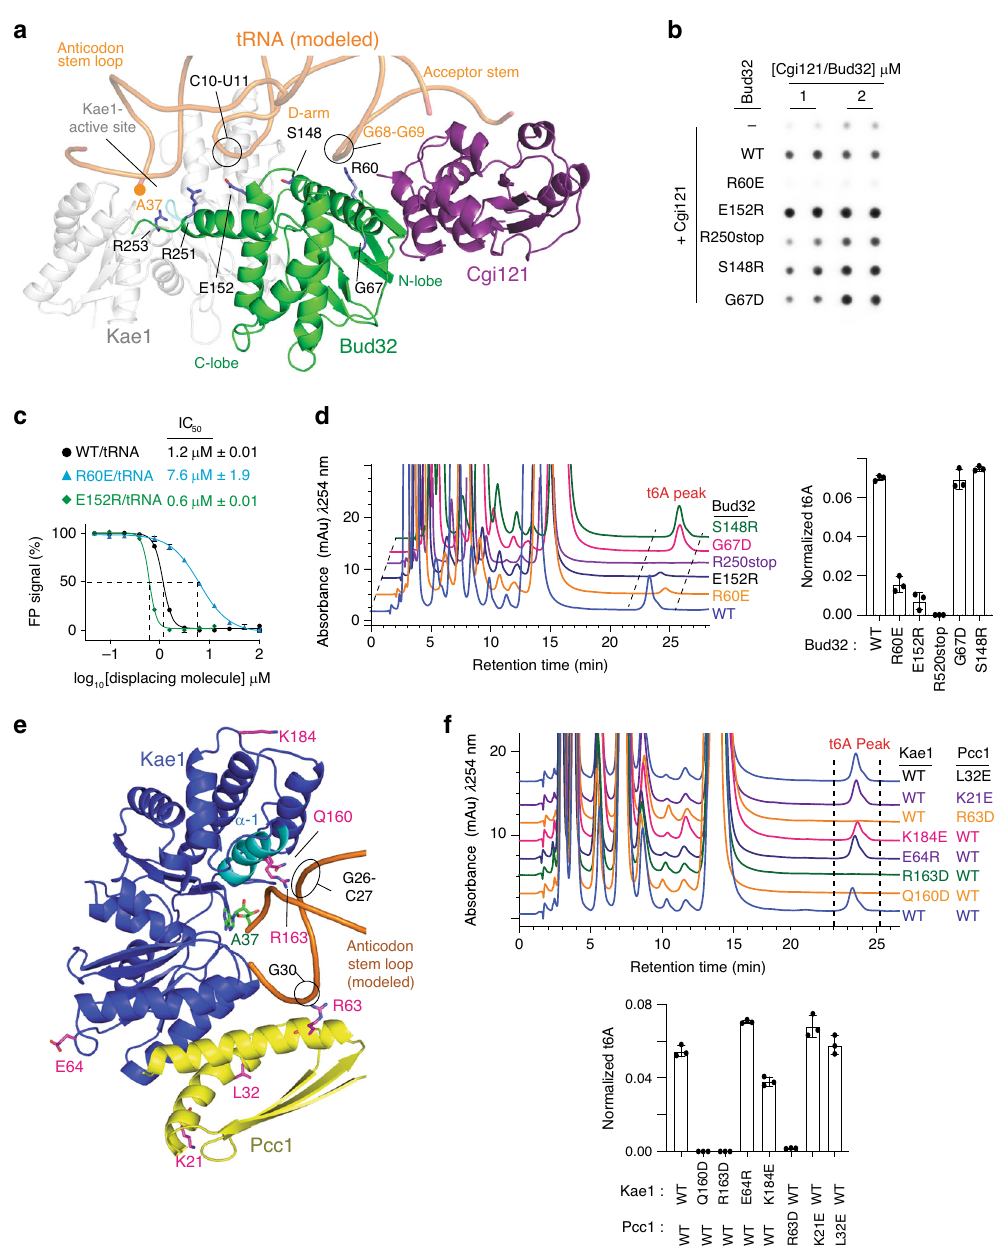
Fig. 5 All KEOPS subunits contribute to a binding surface for tRNA substrate. a Ribbon representation of the mj Cgi121 – mj Bud32 – mj Kae1 complex bound to modeled tRNA. Residues in close proximity to the tRNA-binding surface of Bud32 that were selected for mutational analysis are shown in stick representation. The Pcc1 subunit was omitted for clarity. b Analysis of tRNA binding by mj Cgi121 – mj Bud32 subcomplexes using a fi lter binding assay. mj Cgi121 was tested alone or in complex with mj Bud32 wild-type or the indicated mutants. c Competitive displacement of a 647-CCA probe from binding to the wild-type mj Cgi121 – mj Bud32 complex or a complex containing the indicated Bud32 mutants by increasing concentration of mj tRNA Lys . Displacement of the 647-CCA probe was monitored by fl uorescence polarization (FP) ( n = 3 independent experiment samples, ±SD). d In vitro t 6 A modi fi cation activity analysis of reconstituted ar KEOPS complexes with wild-type mj Bud32 and the indicated Bud32 mutants. Representative HPLC pro fi les of nucleoside composition for each reaction (left) and quanti fi cation (right) showing the average t 6 A content normalized to the content of uridine ( n = 3 independent experiment samples, ±SD). e Ribbon representation of the mj Cgi121 – mj Bud32 – mj Kae1 – pf Pcc1 complex bound to modeled tRNA. Residues in close proximity to the tRNA-binding surface on Kae1 and Pcc1 that were selected for mutational analysis are shown in stick representation. mj Cgi121 and mj Bud32 were omitted for clarity. f In vitro t 6 A modi fi cation activity analysis of reconstituted ar KEOPS complexes with WT or the indicated Pcc1 and Kae1 mutants. Representative HPLC pro fi les of nucleoside composition for each reaction (top) and quanti fi cation (bottom) showing the average t 6 A content normalized to the content of uridine ( n = 3 independent experiment samples, modi fi cation activity suggesting that the C-terminal tail of Bud32 (Supplementary Fig. 5a). Thus, mutation of the predicted tRNA- binding surface on mj Bud32 has a measurable effect on both the tRNA-binding properties of the mj Cgi121 – mj Bud32 complex and (Fig. 5d). Importantly, all mj Bud32 mutants maintained the on the catalytic function of KEOPS. ability to bind mj Cgi121 to a similar degree as mj Bud32 WT